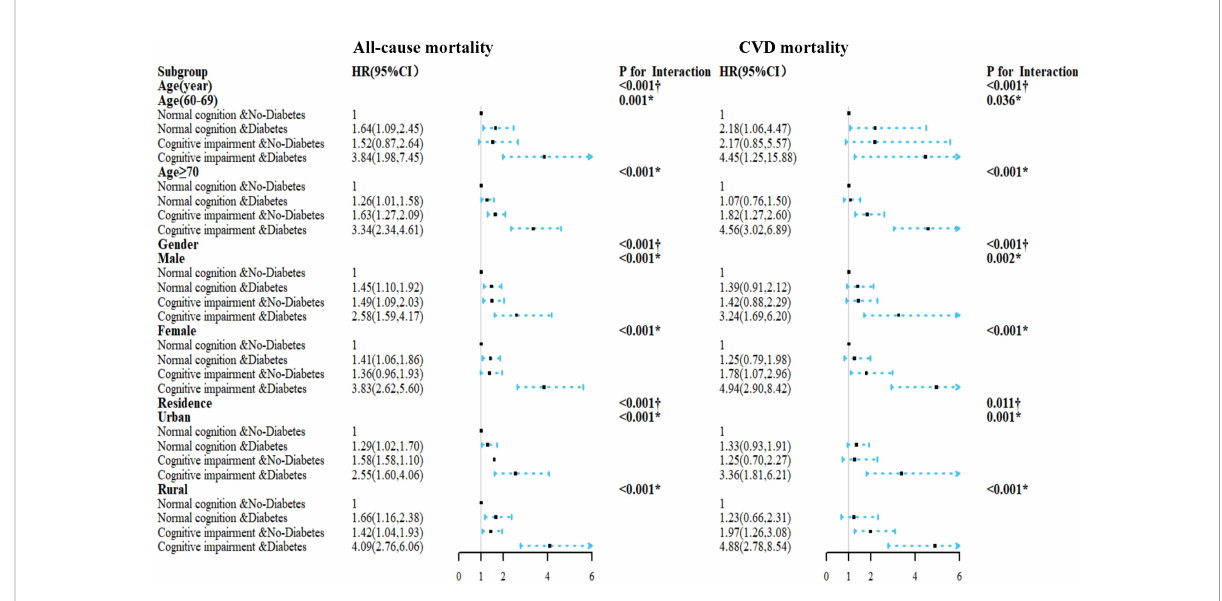
FIGURE 2 HRs for the combined associations of cognition impairment and diabetes mellitus with all-cause and CVD mortality according to the classi fi cation of age, gender, and residence. All models were adjusted for age (not in the age subgroup) and gender (not in the gender subgroup), residence (not in the residence subgroup), education, marriage, smoking status, alcohol drinking, exercise, BMI, WC, chronic diseases (hypertension, dyslipidemia, coronary disease, COPD, and tumor), TC, TG, and uric acid. The estimated HRs for each group are compared with normal cognition and non-diabetes groups. † Interaction between the four-level joint variable of CI/DM and age, gender, or residence subgroup on mortality. *Interaction between diabetes mellitus and cognitive impairment on